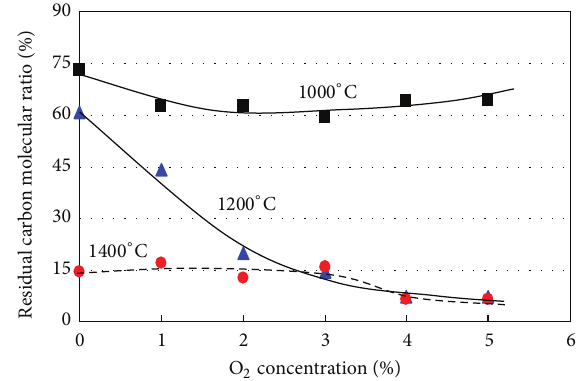
Figure 15: EDS analysis of residual carbon molecular ratios against O 2 % in CO 2 -rich gas